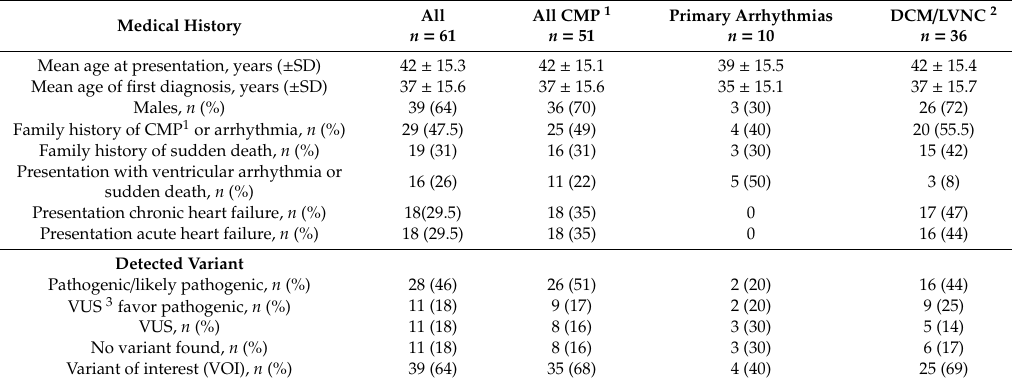
Figure 2. Clinical diagnoses of investigated patient cohort. * survived and non-survived. Table 1. Sum statistics and genetics of the patient